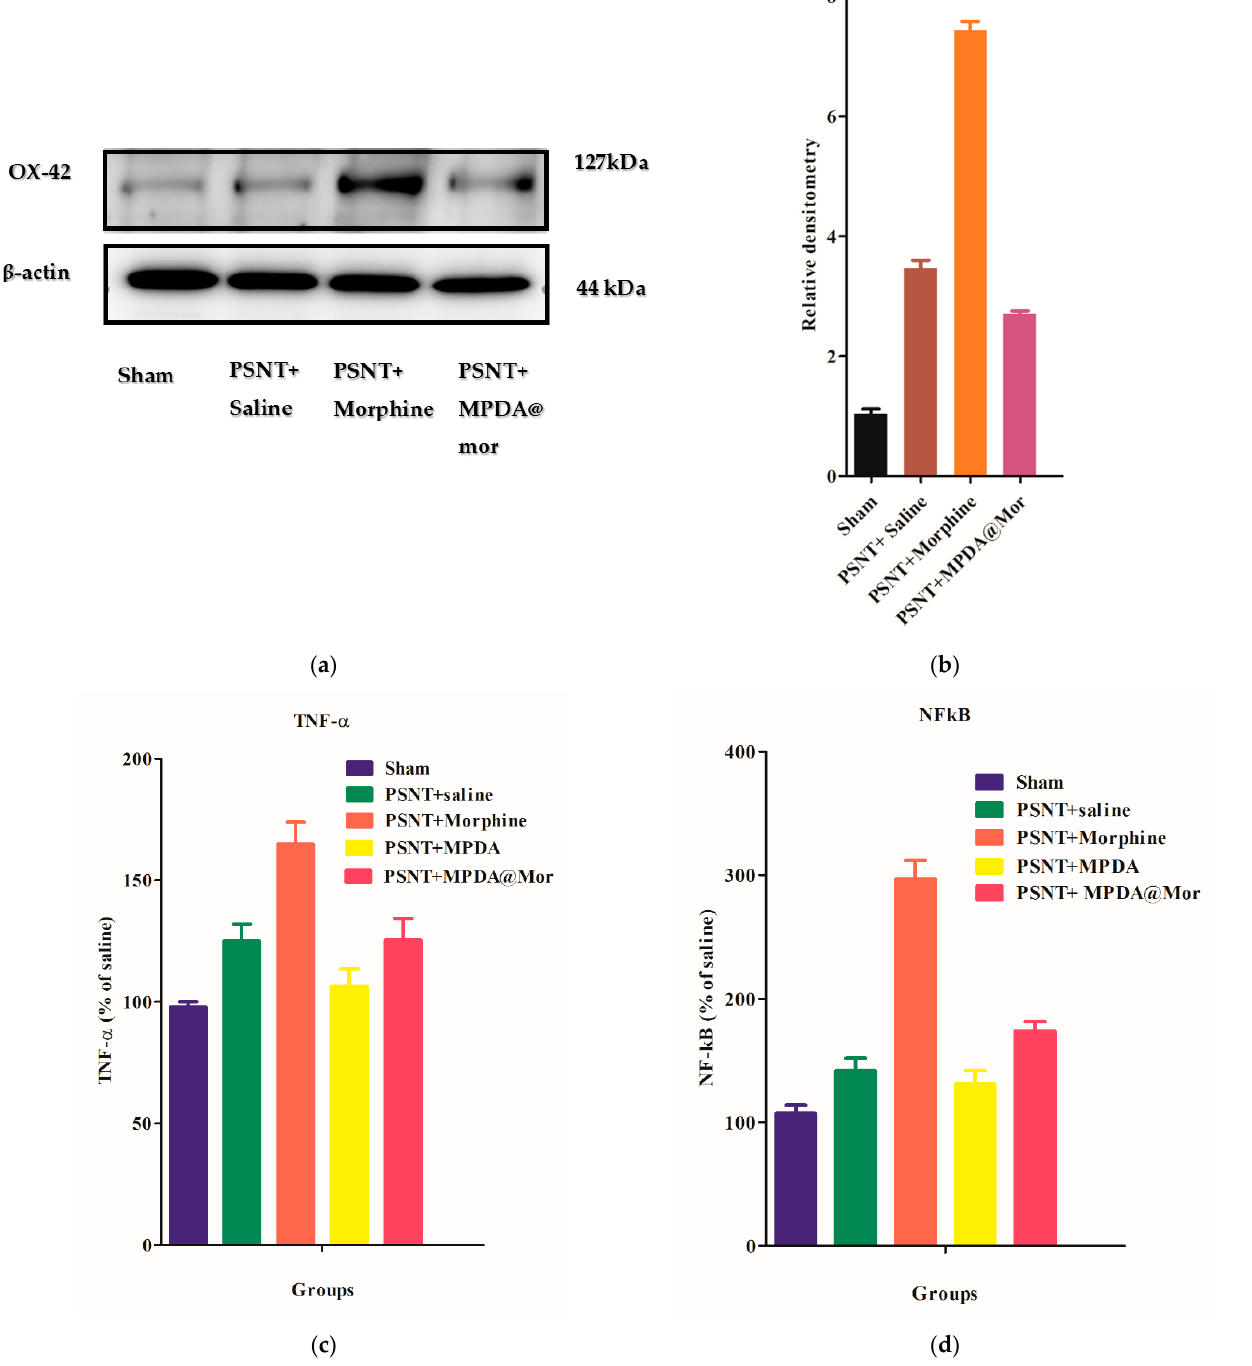
Figure 7. ( a ) Expression of OX-42 in the spinal cord dorsal horn of Sham, PSNT, morphine, and MPDA@Mor groups, immunoblotting of β -actin was used as a control ( b ) Quantification of OX-42 in spinal dorsal horn with Western blotting. Quantification of OX-42 was obtained with densitometric analysis and normalized with β -actin. ( c ) The effect of chronic administration of saline, morphine, MPDA, and MPDA@Mor on TNF- α in rat dorsal root ganglion (DRG). ( d ) The effect of chronic administration of saline, morphine, MPDA, and MPDA@Mor on NFkB in rat DRG.